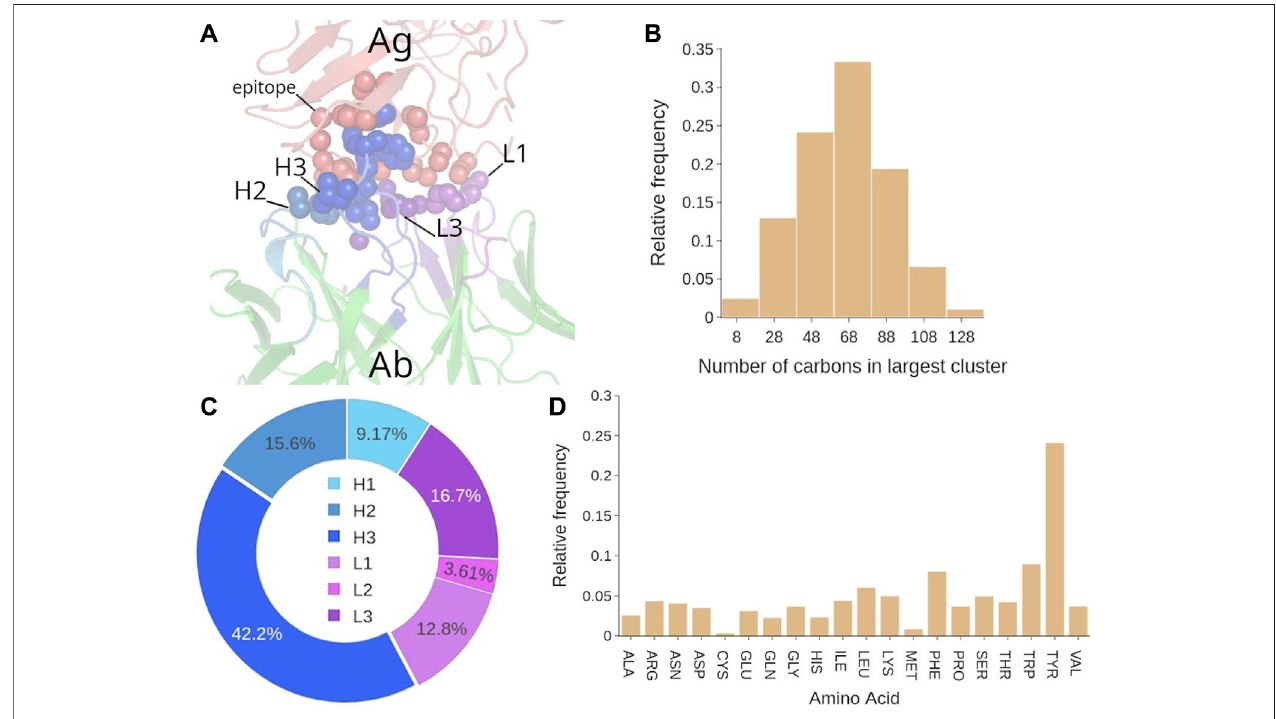
FIGURE 6 | Analysis of the hydrophobic interactions in Ab-Ag complexes. (A) Representative structure of the hydrophobic cluster in the Ab-Ag interface. (B) Number of C atoms that participate in the biggest hydrophobic cluster. (C) Participation (in %) of each CDR to the biggest hydrophobic cluster. (D) Amino acid contribution in the biggest hydrophobic cluster, computed by counting the number of carbon atoms contributed by that amino acid type to the cluster.